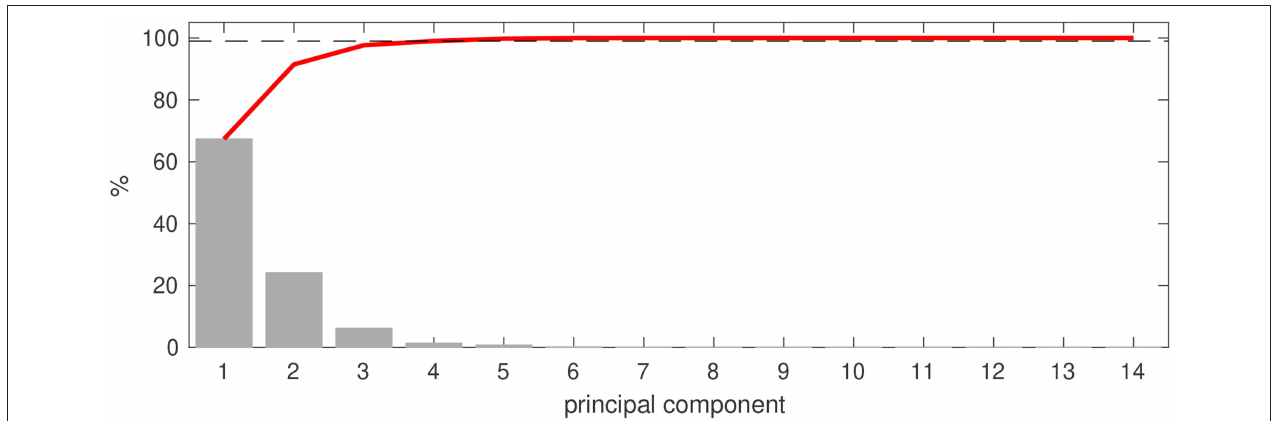
FIGURE 4 | Importance of principal components. Portion of total variance in the training data explained by each of the 14 principal components as well as cumulative sum (red line) for z = 30. Dashed line shows used p min =